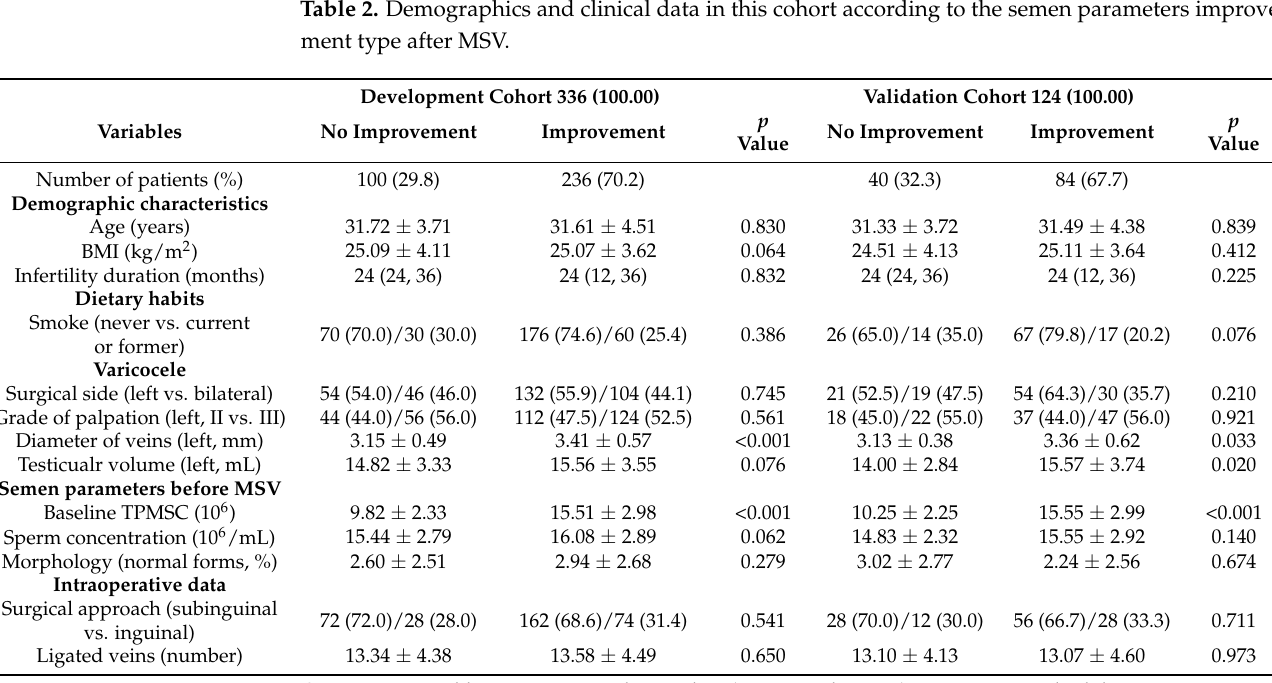
Table 2. Demographics and clinical data in this cohort according to the semen parameters improve- ment type after